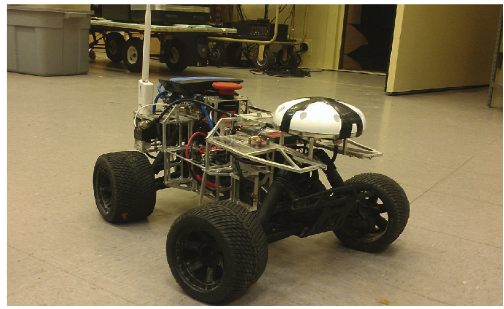
Figure 13: Experimental testing